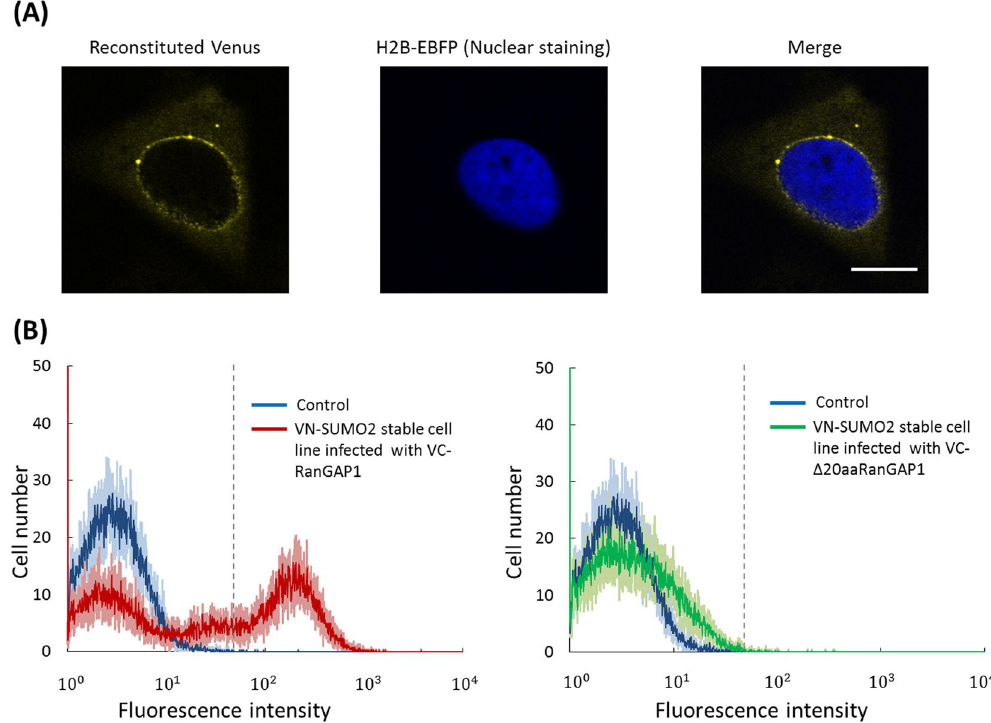
Figure 2. Evaluation of the probes by using SUMOylated protein RanGAP1. ( A ) Fluorescence images of the VN-SUMO2 stable cell lines transiently expressing VC-RanGAP1 and H2B-EBFP. Scale bar: 10 μ m. ( B ) Fluorescence intensities of the non-infected VN-SUMO2 stable cell lines (control cells) and the VN-SUMO2 stable cell lines infected with VC-RanGAP1 (left) or VC- Δ 20aaRanGAP1 (right) were analyzed by FACS. Each histogram was obtained from measurements of 5,000 cells and the measurements were repeated 5 times. Blue, red, and green lines indicate the average of the 5 measurements of control cells, VC-RanGAP1-infected cells, and VC- Δ 20aaRanGAP1-infected cells, respectively. Light blue, light red, light green indicate the respective standard deviation. Dotted gray lines indicate the point where cell number of control cells is almost